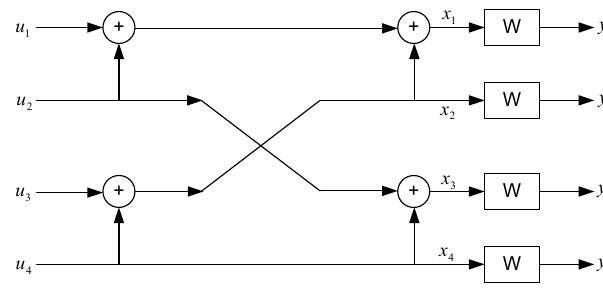
Figure 3: Polar encoding unit for 𝑁 = 4 . The decoding unit of Figure 3 can be drawn as in Figure 4.